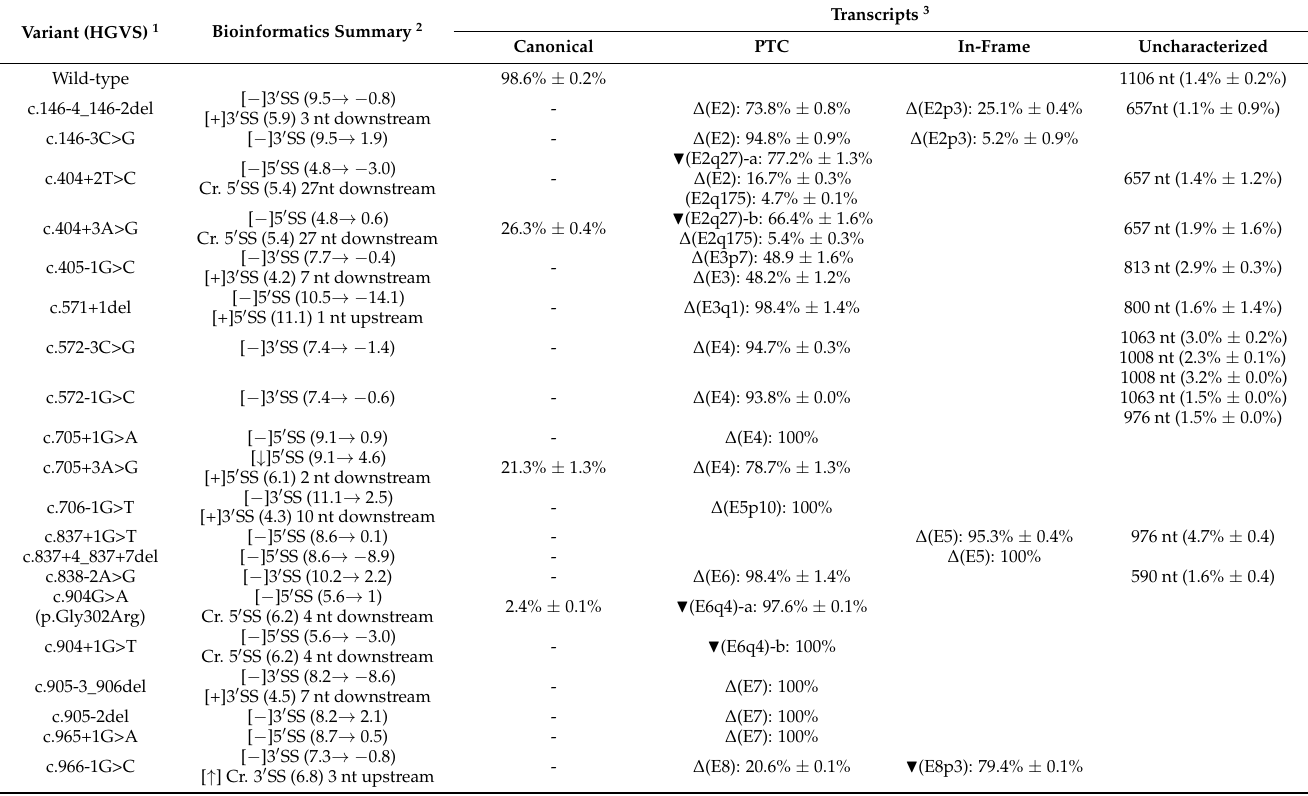
Table 1. Bioinformatics analysis and splicing outcomes of RAD51C canonical splice